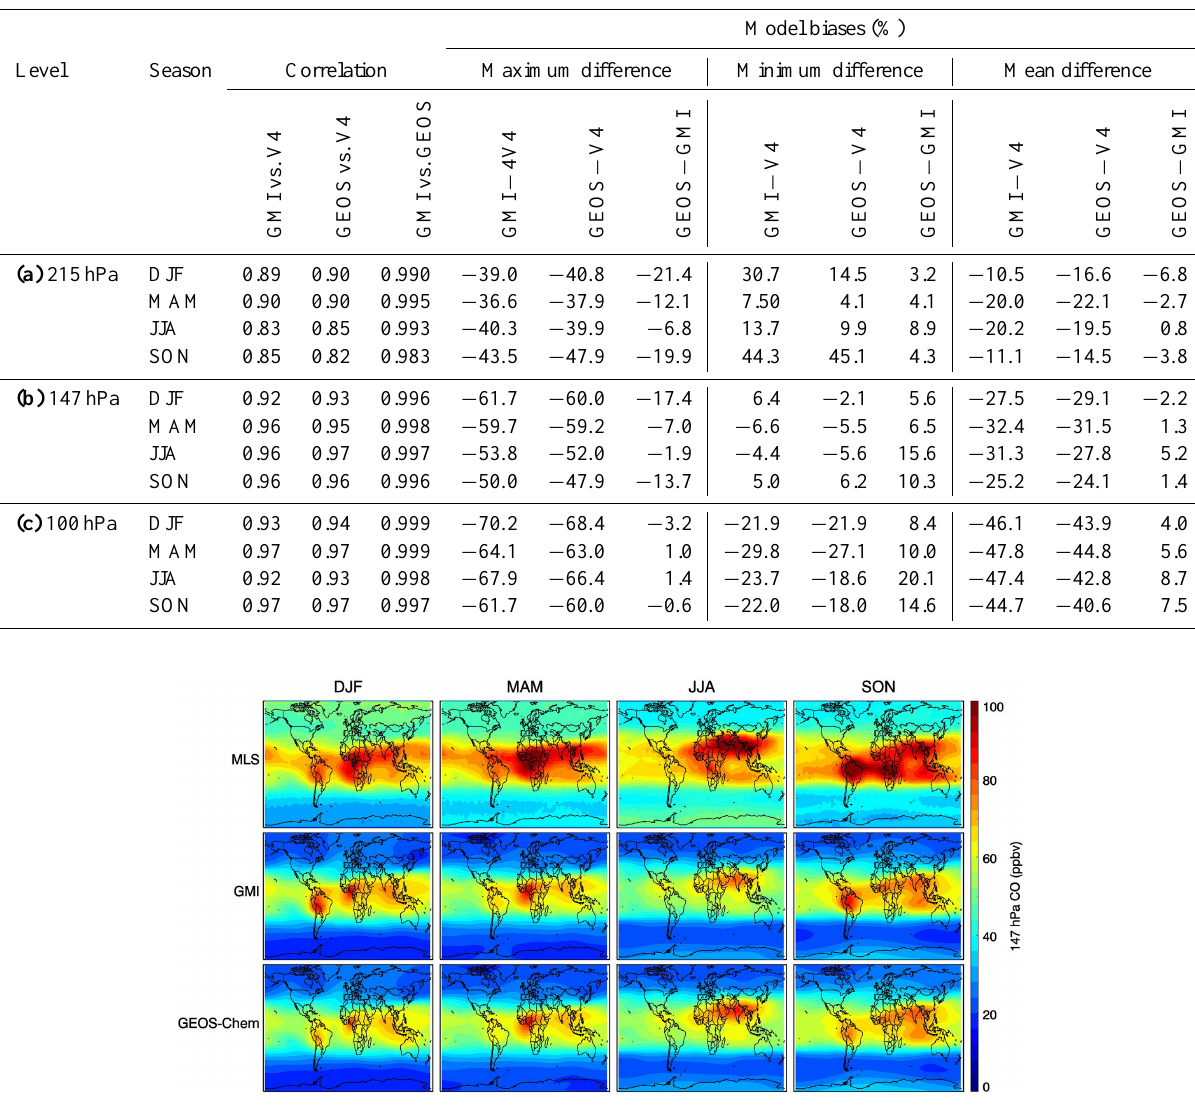
Table 3. Statistical comparison of model-simulated and MLS-observed (V4) CO at (a) 215hPa, (b) 147hPa and (c) 100hPa during each season.